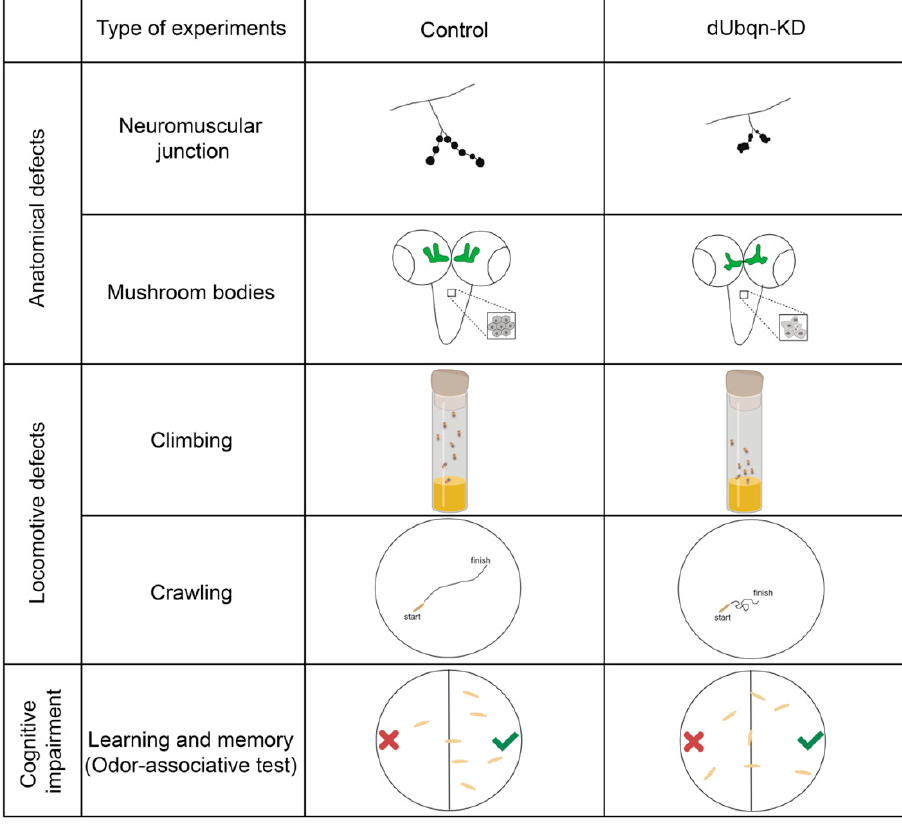
Figure 3. Overview of defects caused by UBQLN2 loss-of-function in Drosophila models [33,152].